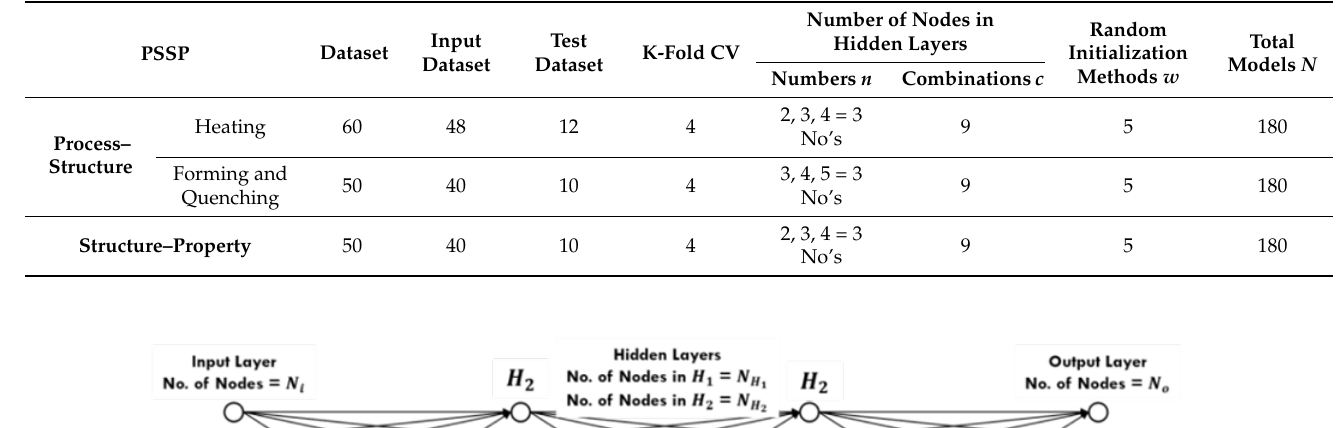
Table 3. Summary of the Models Generated.